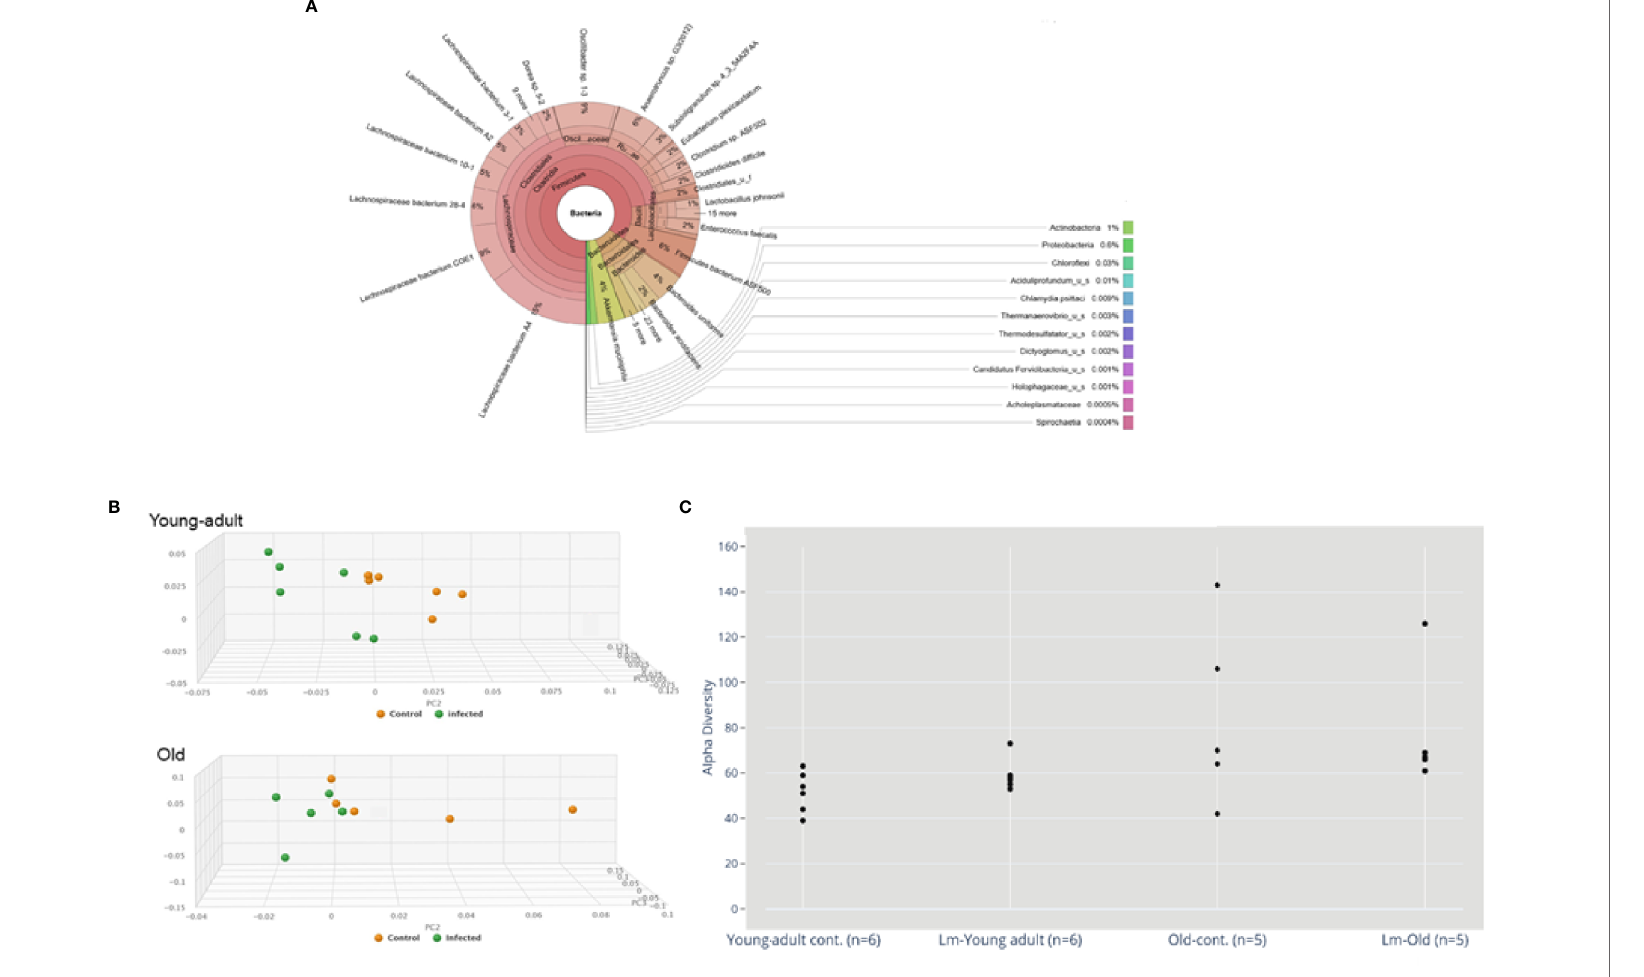
FIGURE 1 | (A) Krona visualization of all bacteria detected across all mice tested. (B) Principal component analysis (PCA) of the fecal microbiota from young-adult and old C57BL/6mice infected with Listeria monocytogenes (Lm) after 7-days post infection. The clustering on two PCA plots show control (uninfected) versus L. monocytogenes infected mice. Each symbol represents one mouse. Principal component analysis scores are plotted based on the relative abundance of total microbiota. Proportion of variance in each principal coordinate axis is denoted in the corresponding axis label. The uninfected control (brown circle) and infected mice (green circle) show clear separation. (C) Alpha diversity comparisons based on CHAO1. Listeria infection in old mice signi fi cantly lowers microbial richness compared with the uninfected old control